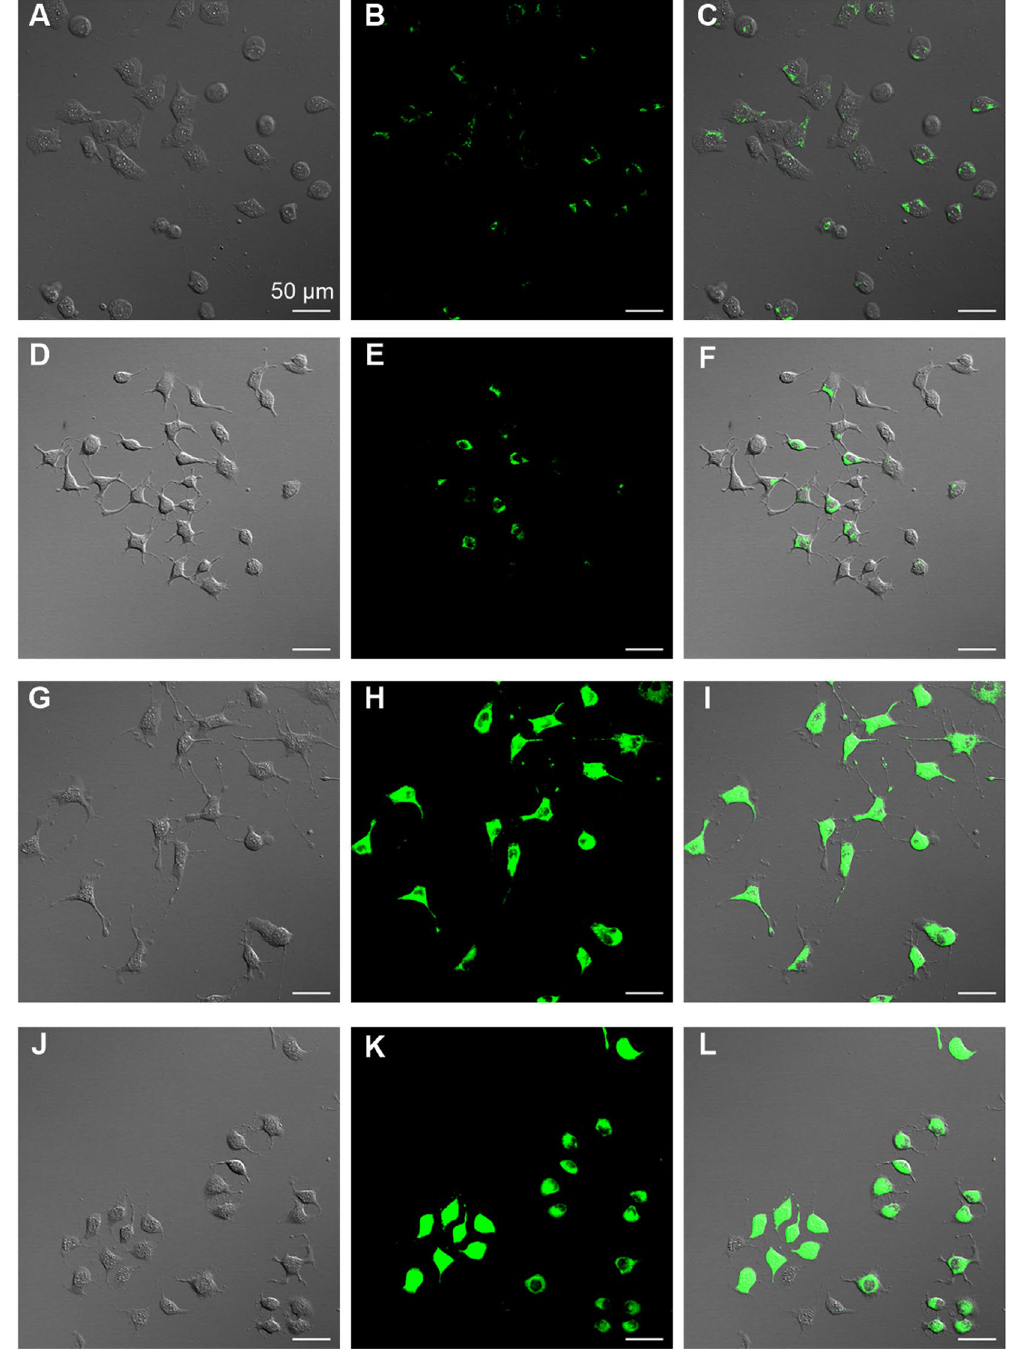
Figure 4. Effects of micellar carriers on the cellular uptake of Rho123 by BCECs. Bright field, fluorescence and merged images for BCECs incubated in free Rho123 ( A – C ), F127/ Rho123 ( D – F ), TPGS/Rho123 ( G – I ), FT/ Rho123 ( J – L ). Scale bar, 50 µ